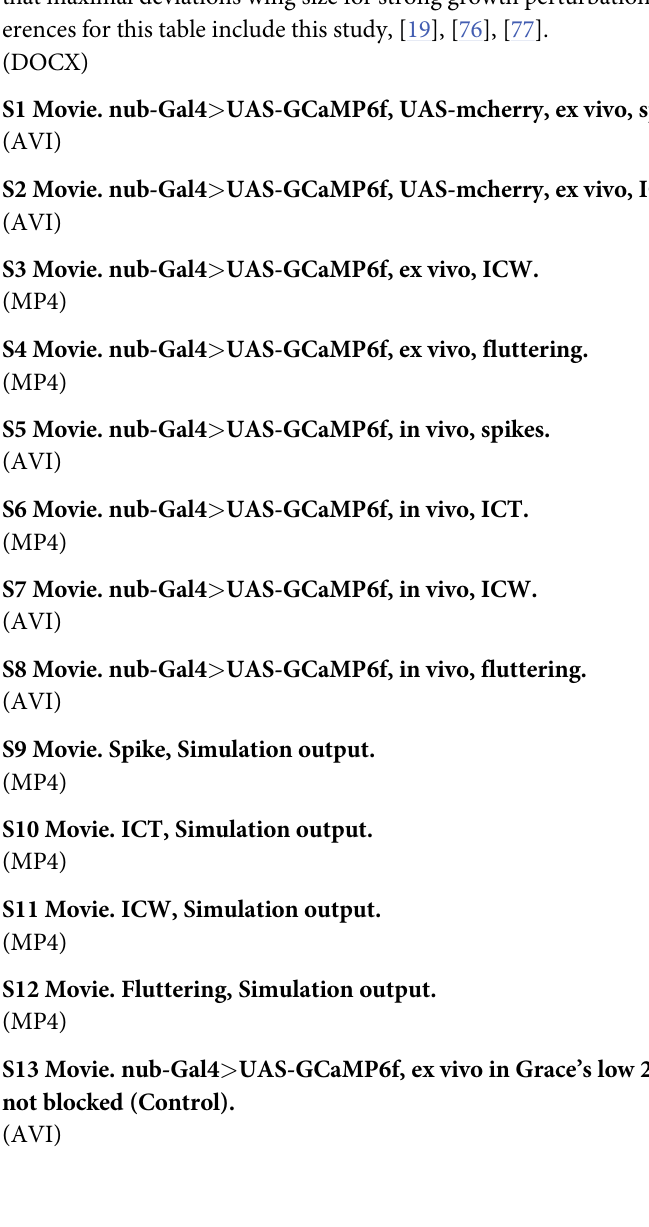
in the case of enabled gap junction communication, or spiking activity in the case of disabled gap junction communication, only two classes of activity appear. In each classification run, there were no differences in the user-recorded classifications. (D) The proportions of Ca 2+ activity are plotted for Fig 4‘s repeated simulations. Runs 1, 2, and 4 all had the same propor- tions, indicating reproducibility of the simulations’ outputs. Run 3 had mismatched classifica- tions between the ICT and spike class (red arrow), however, the difference in proportions was not significant using a proportions test without a continuity correction. S1 Table. Extended data movies. (DOCX) S2 Table. Changes in wing area for known perturbations through Gal4/UAS system. Note that maximal deviations wing size for strong growth perturbations is in range of 20–50%. Ref- erences for this table include this study, [19], [76],